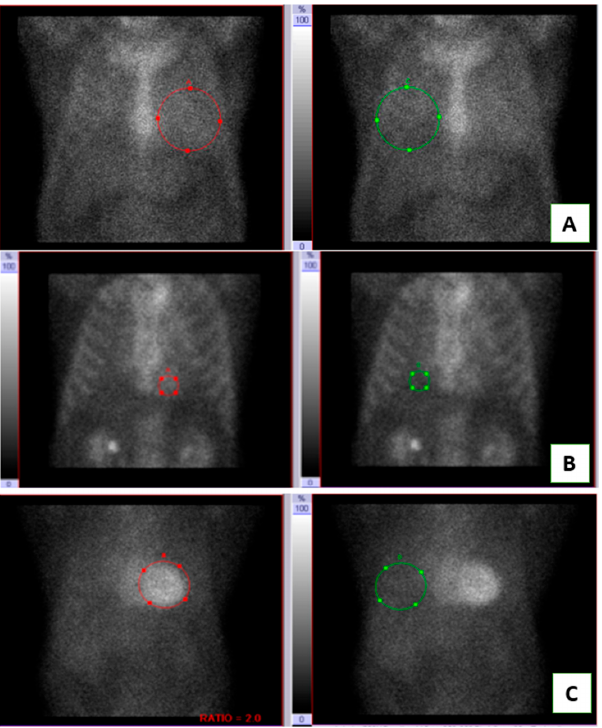
Figure 1. An example of planar PYP scan images of low, intermediate, and high uptake groups: ( A ) Low uptake with Heart/Contralateral lung (H/CL) ratio 1.1, ( B ) Intermediate uptake with H/CL ratio = 1.3, ( C ) High uptake with H/CL ratio = 2.0. Red: heart uptake, Green: contralateral lung uptake.